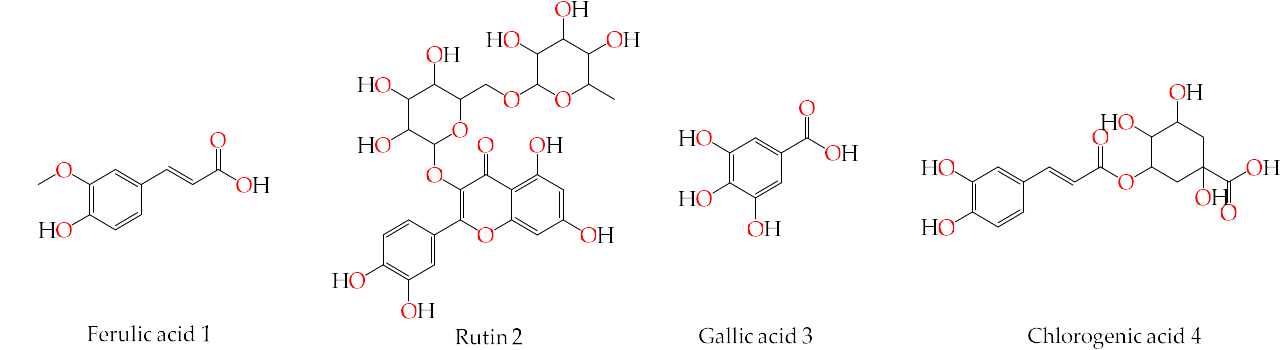
Figure 1. Chemical structures of the isolated bioactive phenolic compounds (ferulic acid 1, rutin 2, gallic acid 3, and chloro- genic acid 4) from the leaves of Pimenta dioica (L.) Merr.